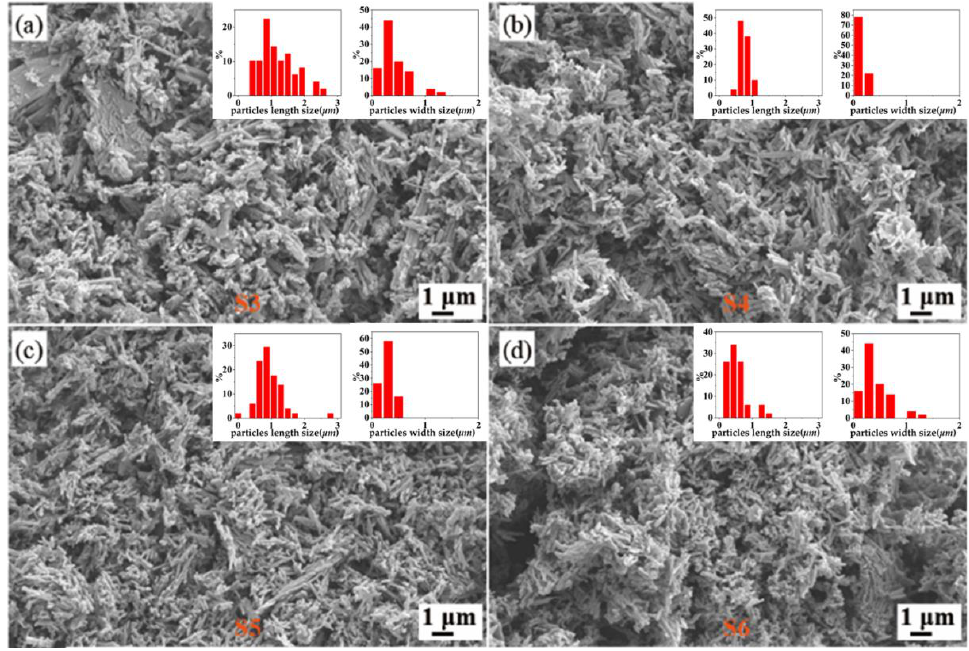
Figure 3. SEM images of ( a ) S3 (reactants ratio 1.5:1), ( b ) S4 (reactants ratio 2:1), ( c ) S5 (reactants ra-